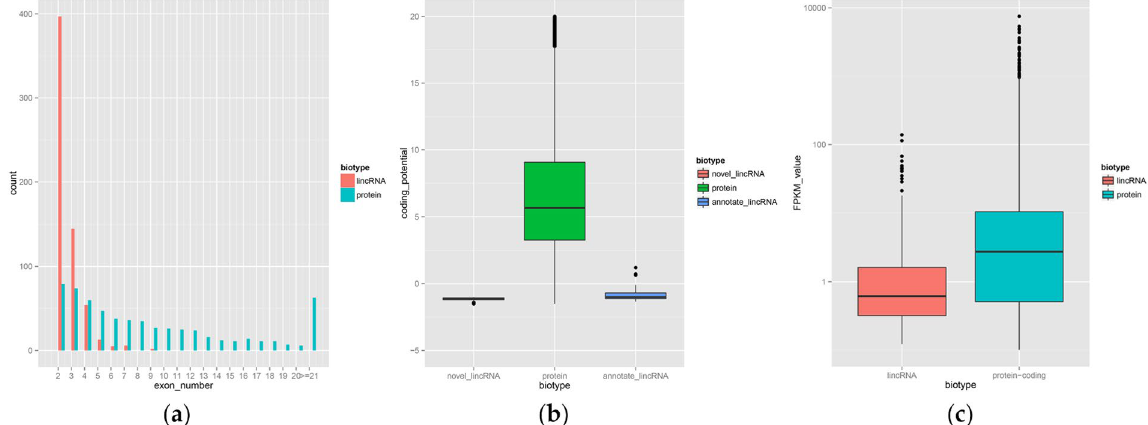
Figure 5. Characteristics of lincRNAs. ( a ) Comparison of exon number between the novel lincRNA and protein_ coding gene. ( b ) Comparison of coding potential among the identified lincRNA and the annotated lincRNA and protein_coding gene. ( c ) Comparison of expression level between lincRNA and protein_coding